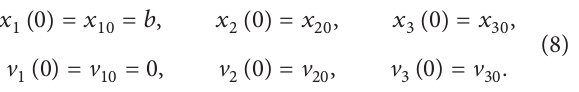
/𝐾 𝑏 = 𝐵𝐾 1 1 , 𝛾 = 𝜁 /𝑘 𝑖 𝑖 have been